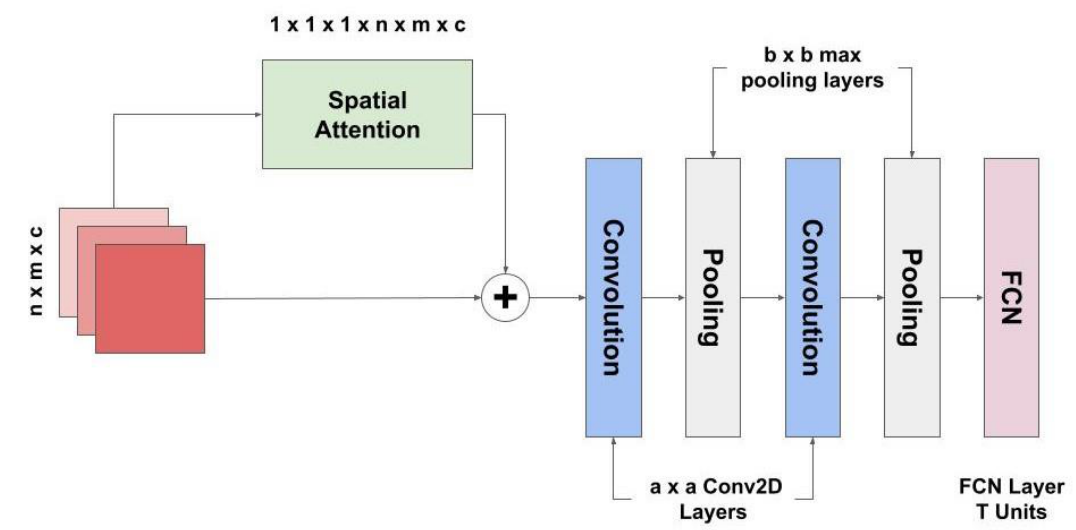
Figure 7. Process of spatial attention is added to enhance features before they are fed into CNN.